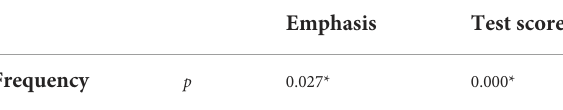
TABLE 2 Spearman correlation analysis of frequency, emphasis, and the test